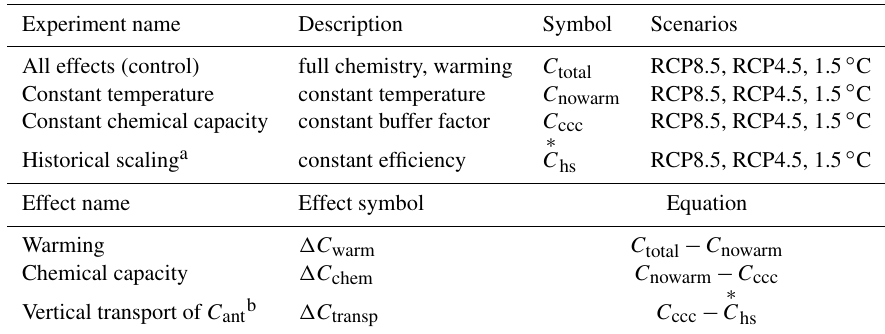
Table 1. Experiments with the IRF model, historical scaling, and the effects quantified by